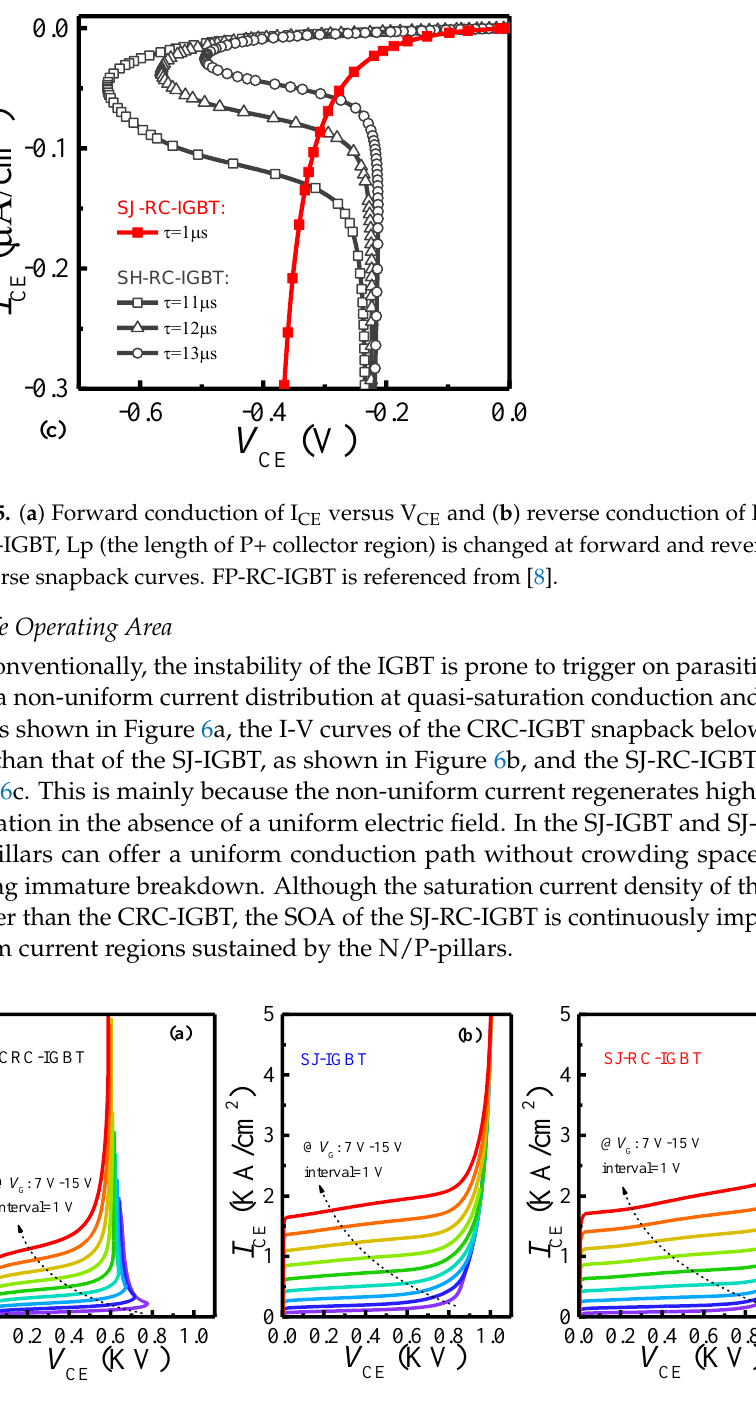
Figure 6. I-V characteristics of three IGBTs with a ramp-up V G from 7 V to 15 V(The lines from blue- purple to red indicate increase in V G from 1V to 5V with 1 V interval.): ( a ) I-V characteristics of CRC- IGBT, ( b ) I-V characteristics of SJ-IGBT, and ( c ) I-V characteristics of SJ-RC-IGBT.